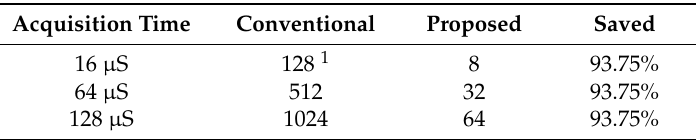
Table 2. Computational Complexity Required.